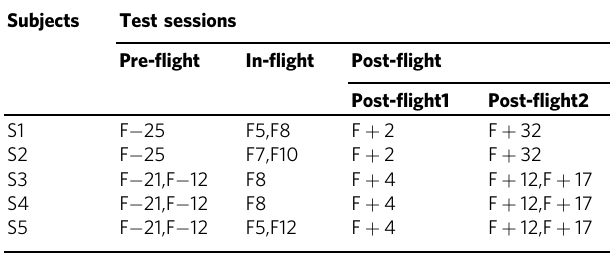
Table 1 The test schedules for the space